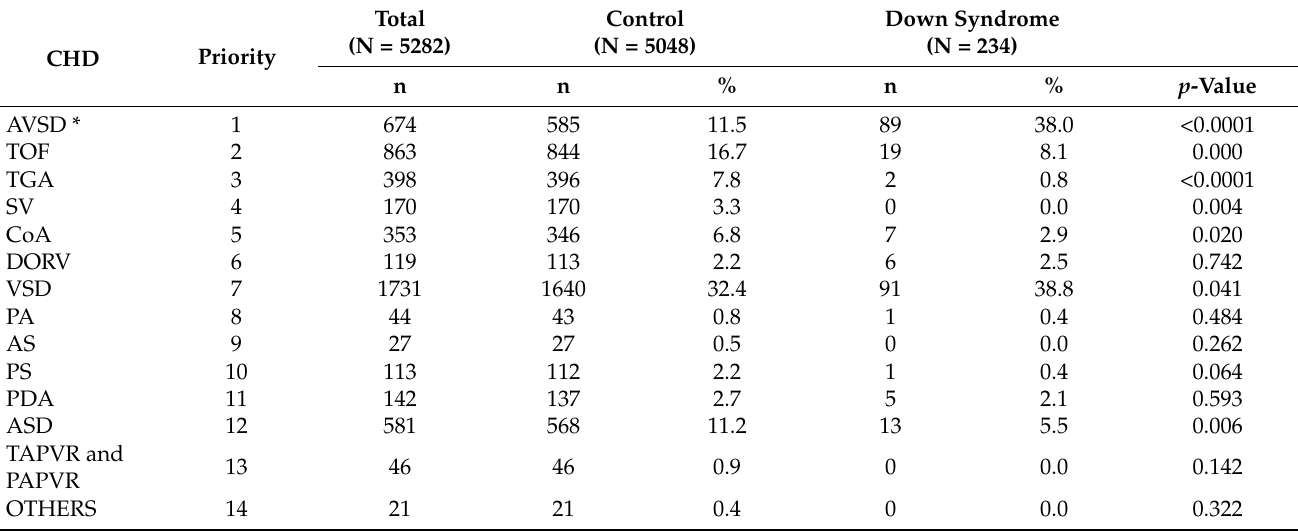
Table 2. The preoperative distribution of congenital heart disease in subjects with and without Down syndrome.